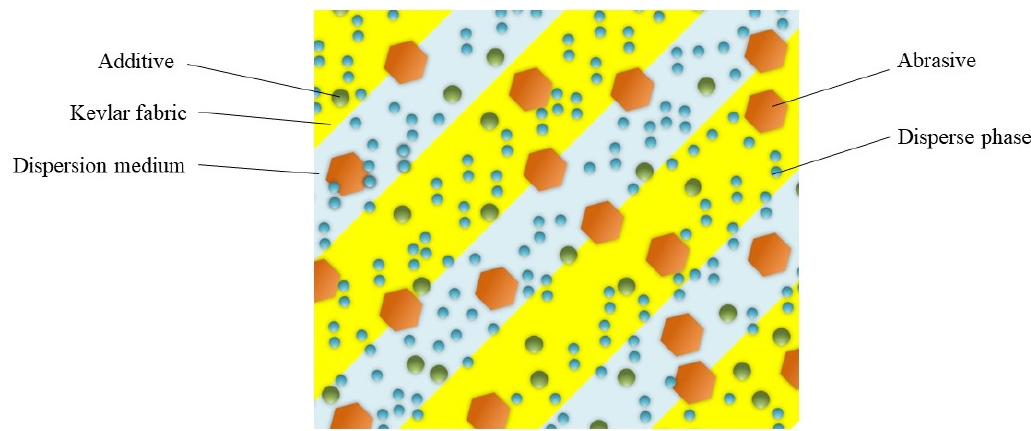
Figure 1. The mechanism of shear-thickening cluster effect.